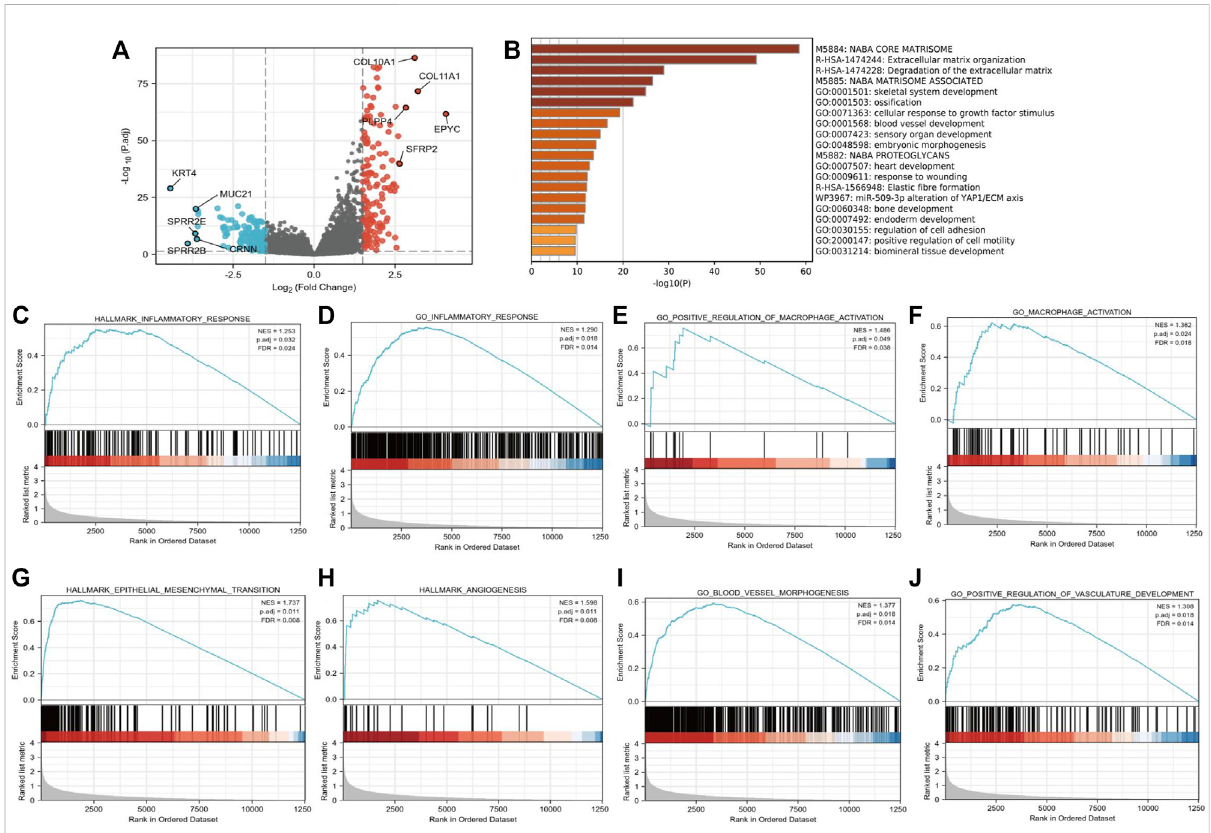
FIGURE 3 Functional annotation of differentially expressed genes (DEGs) in gastric cancer patients with distinct CTHRC1 levels. (A) Volcano plots of the DEGs with the top 10 DEGs. (B) Pathways enriched in CTHRC1 high groups using Metascape database. (C – J) Representative Gene Set Enrichment Analysis between CTHRC1 high and CTHRC1 low expression